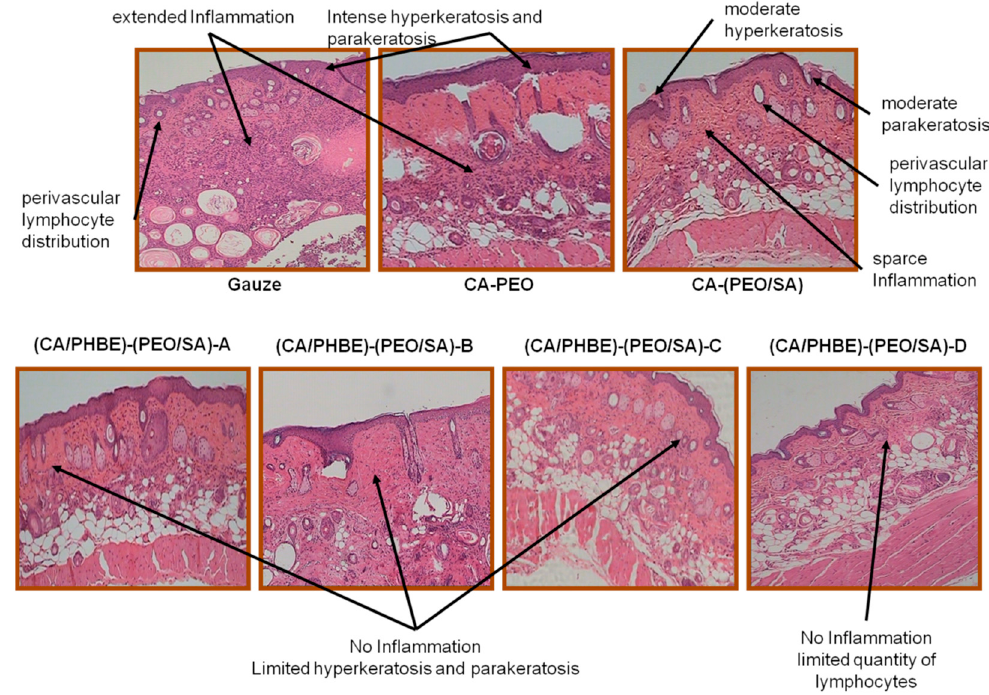
Figure 5. Histological evaluation: skin sections of the different mice groups (magni fi cation 100×).